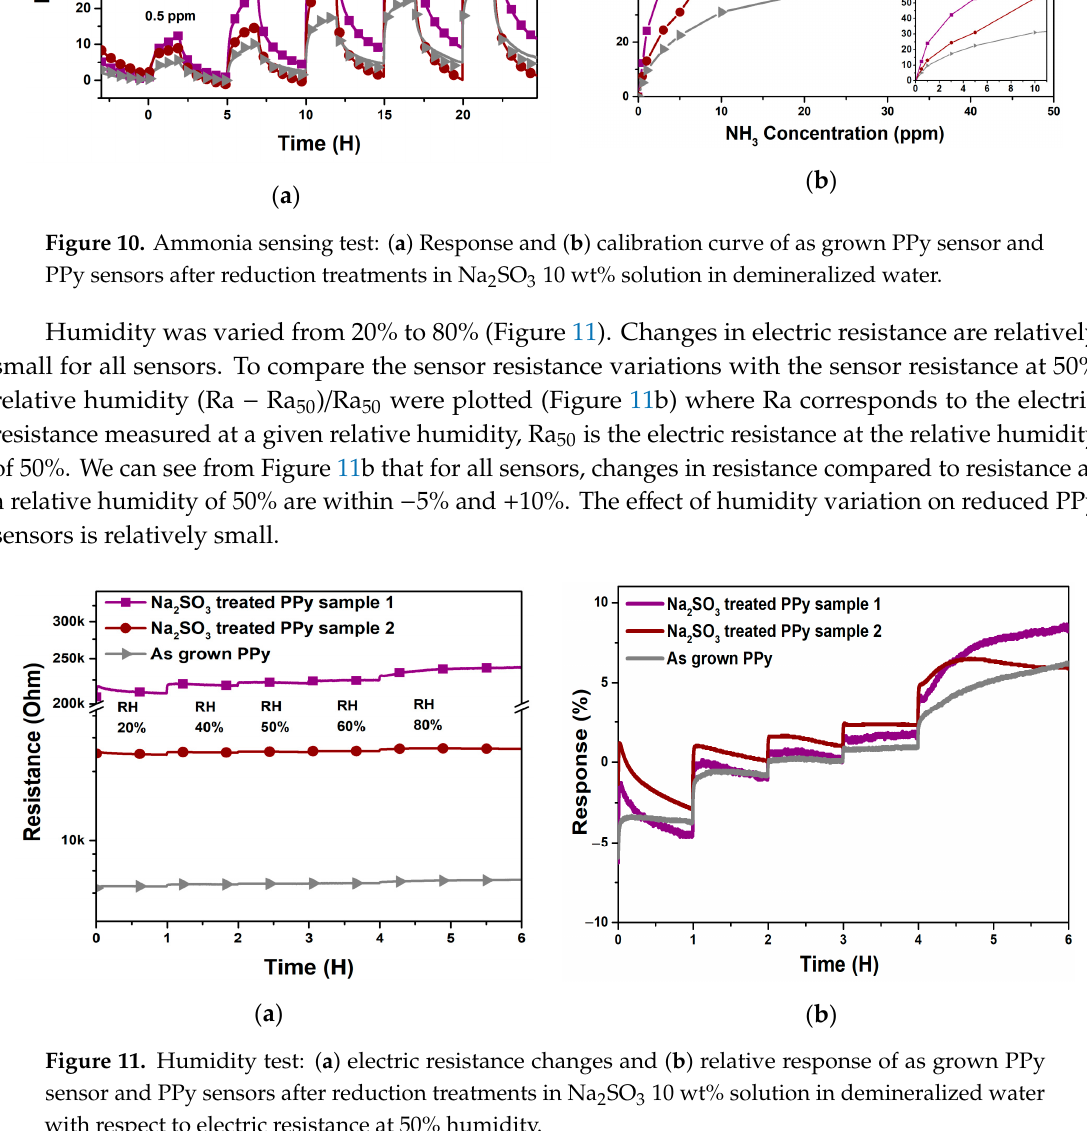
Figure 11. Humidity test: ( a ) electric resistance changes and ( b ) relative response of as grown PPy sensor and PPy sensors after reduction treatments in Na 2 SO 3 10 wt% solution in demineralized water with respect to electric resistance at 50% humidity.